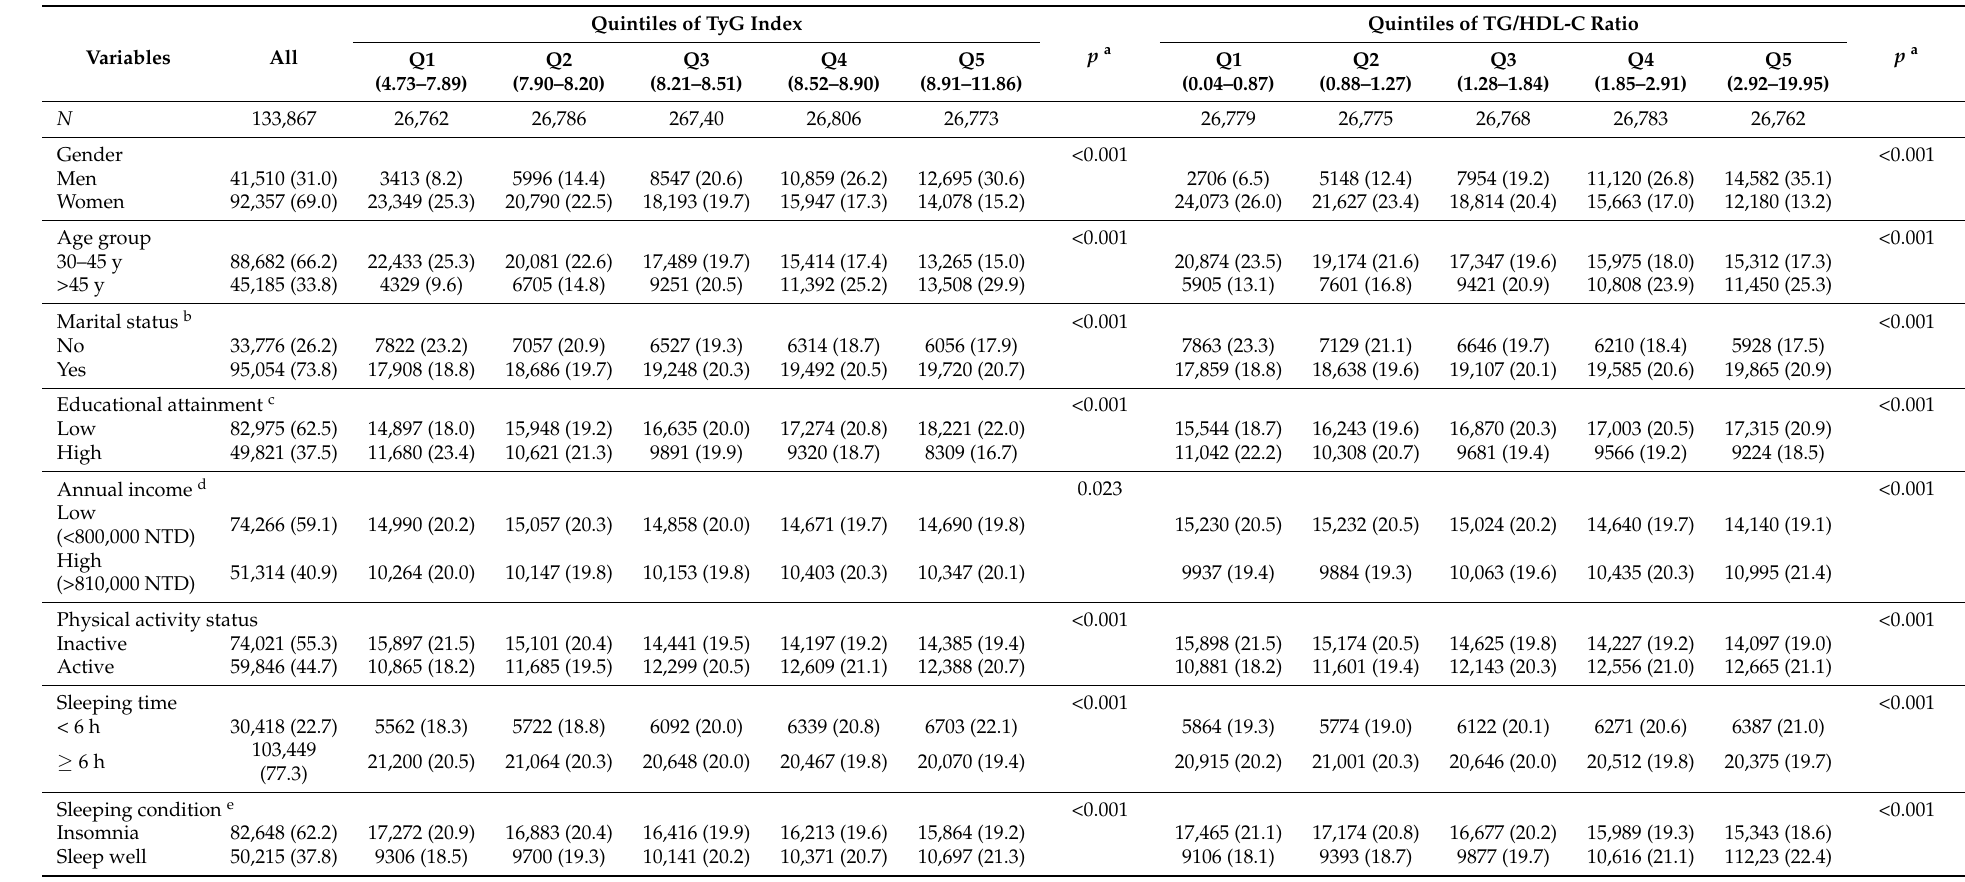
Table 1. Characteristics of the participants according to quintiles of TyG index and TG/HDL-C